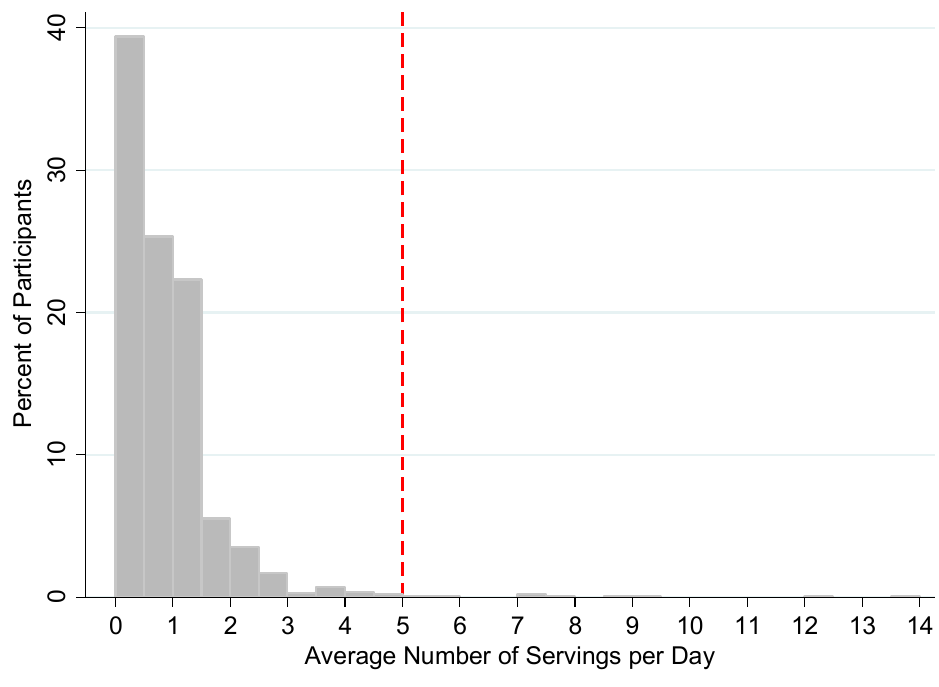
Figure 1. Average daily consumption of fruits and vegetables among study participants. Note: red dotted line indicates World Health Organization recommendation for daily servings of fruits and vegetables. Table 3. Associations between sociodemographic characteristics and servings per week of fruit and vegetable consumption among the study population.